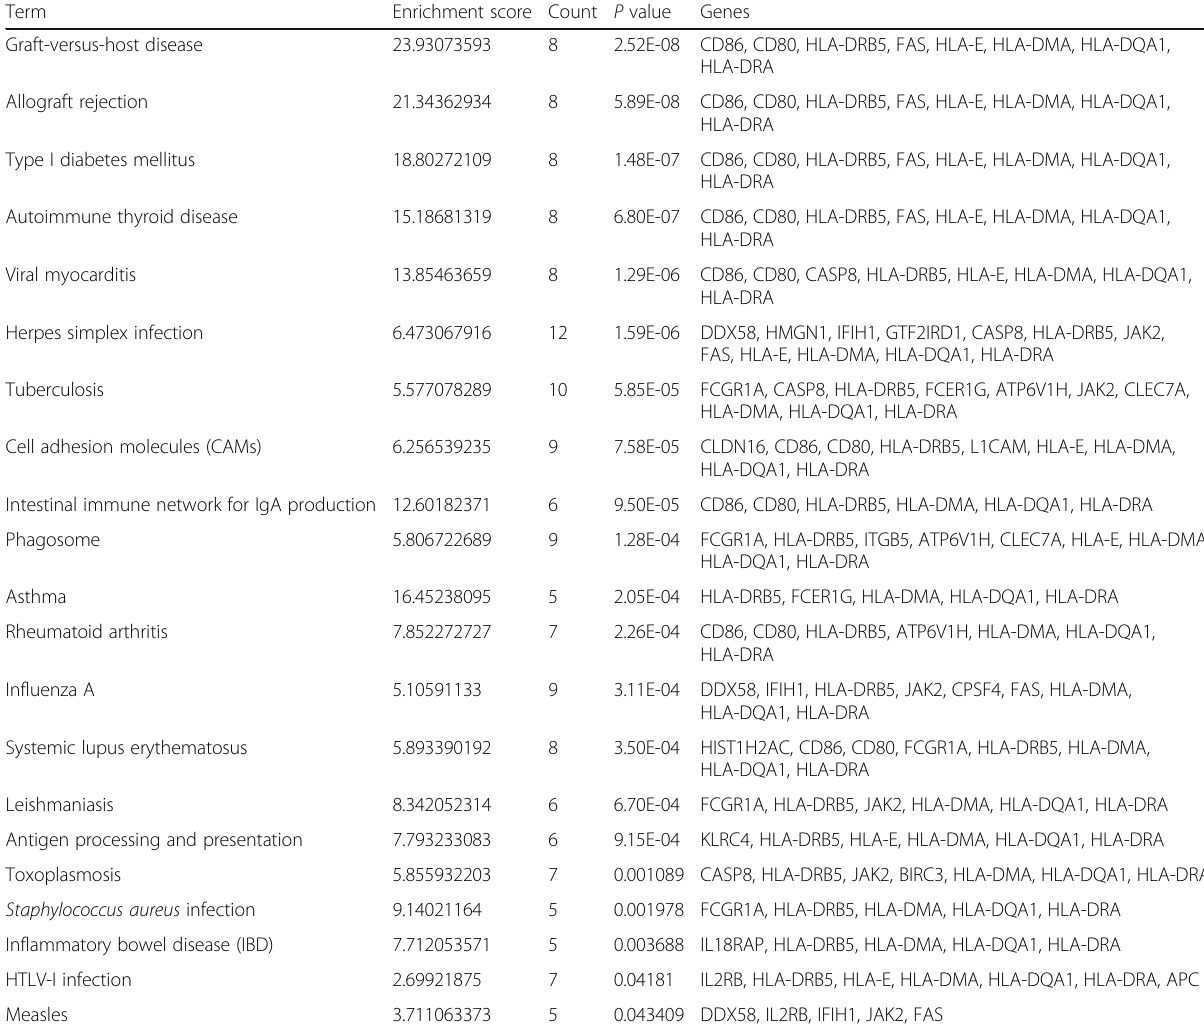
Table 1 KEGG pathway enrichment analysis for differentially expressed genes